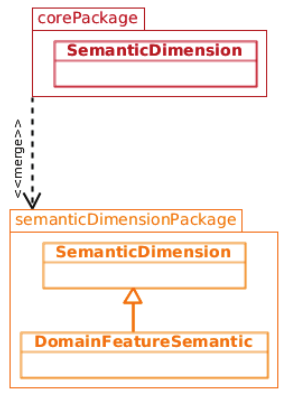
Figure 5: Semantic dimension